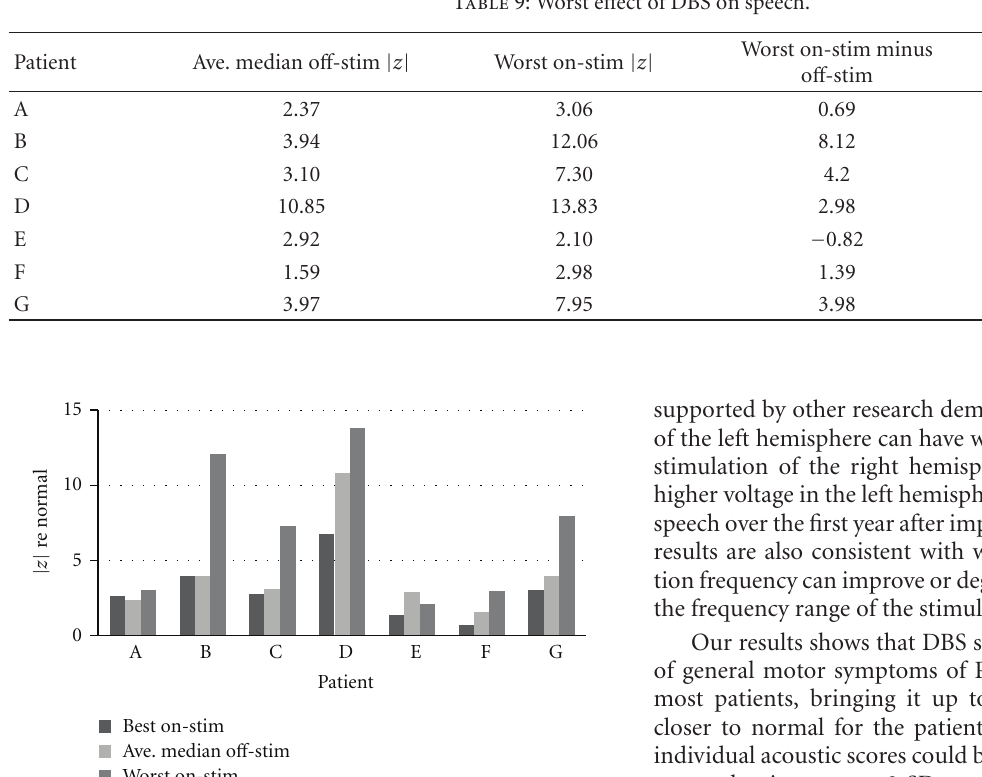
the five measures that di ff erentiate PD speech from normal are taken together, they show how patients move closer to or farther away from the normal range of function as DBS settings that are intended to relieve motor symptoms